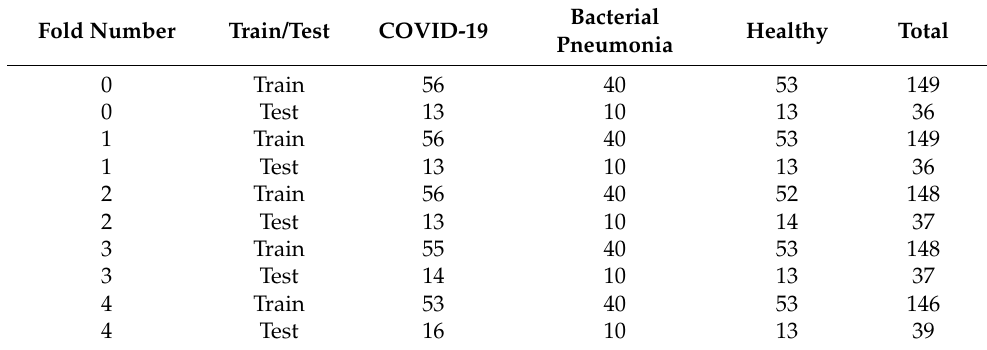
Table 2. Distribution of classes in 5 partitions separated by training and testing.